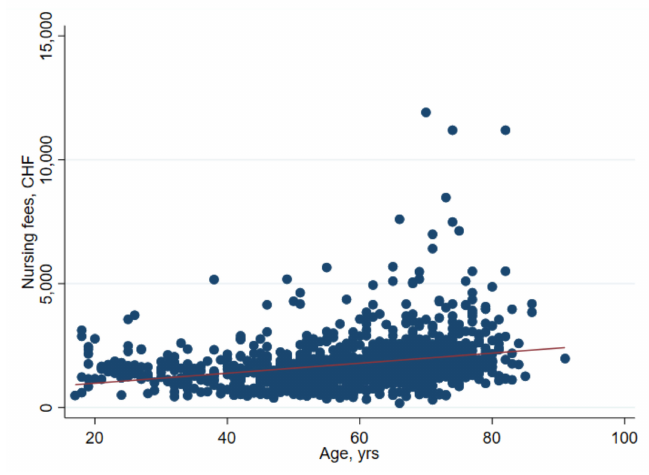
Figure 3. Correlation of age and nursing costs-nursing costs increase with age.